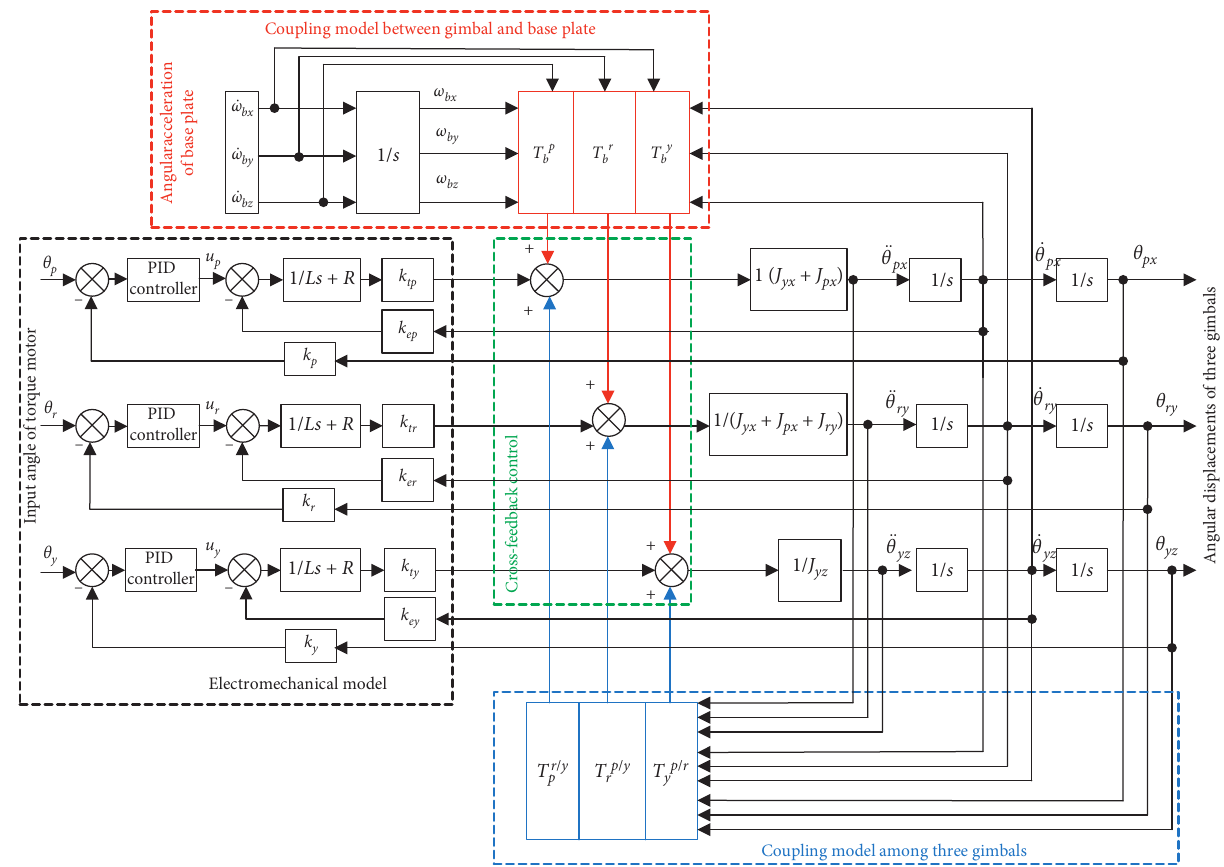
Figure 10: Control diagram of three-axis ISP.